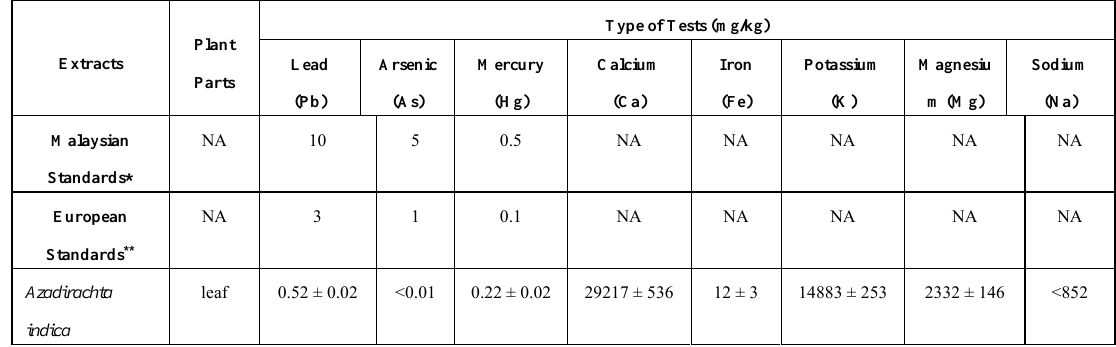
Table 5. Elemental analysis of selected Malaysian plant